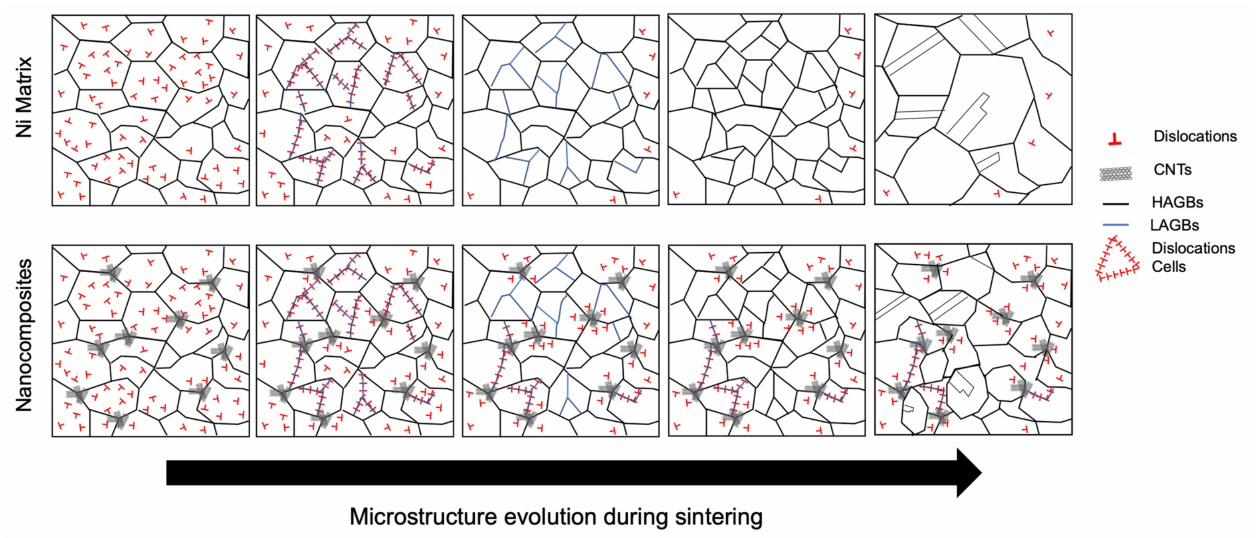
Figure 15. Schematic representation of the proposed effect of the CNTs on the microstructural evolution of the nanocompos- ites during sintering (HAGBs and LAGBs: high- and low-angle grain boundaries,